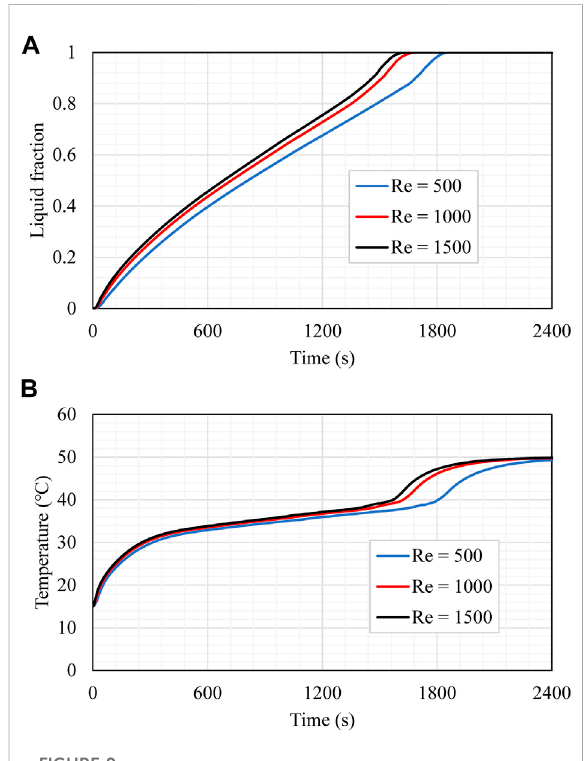
FIGURE 10 (A) Liquid fraction and (B) mean temperature rising of the PCM for different values of HTF inlet temperature during the melting